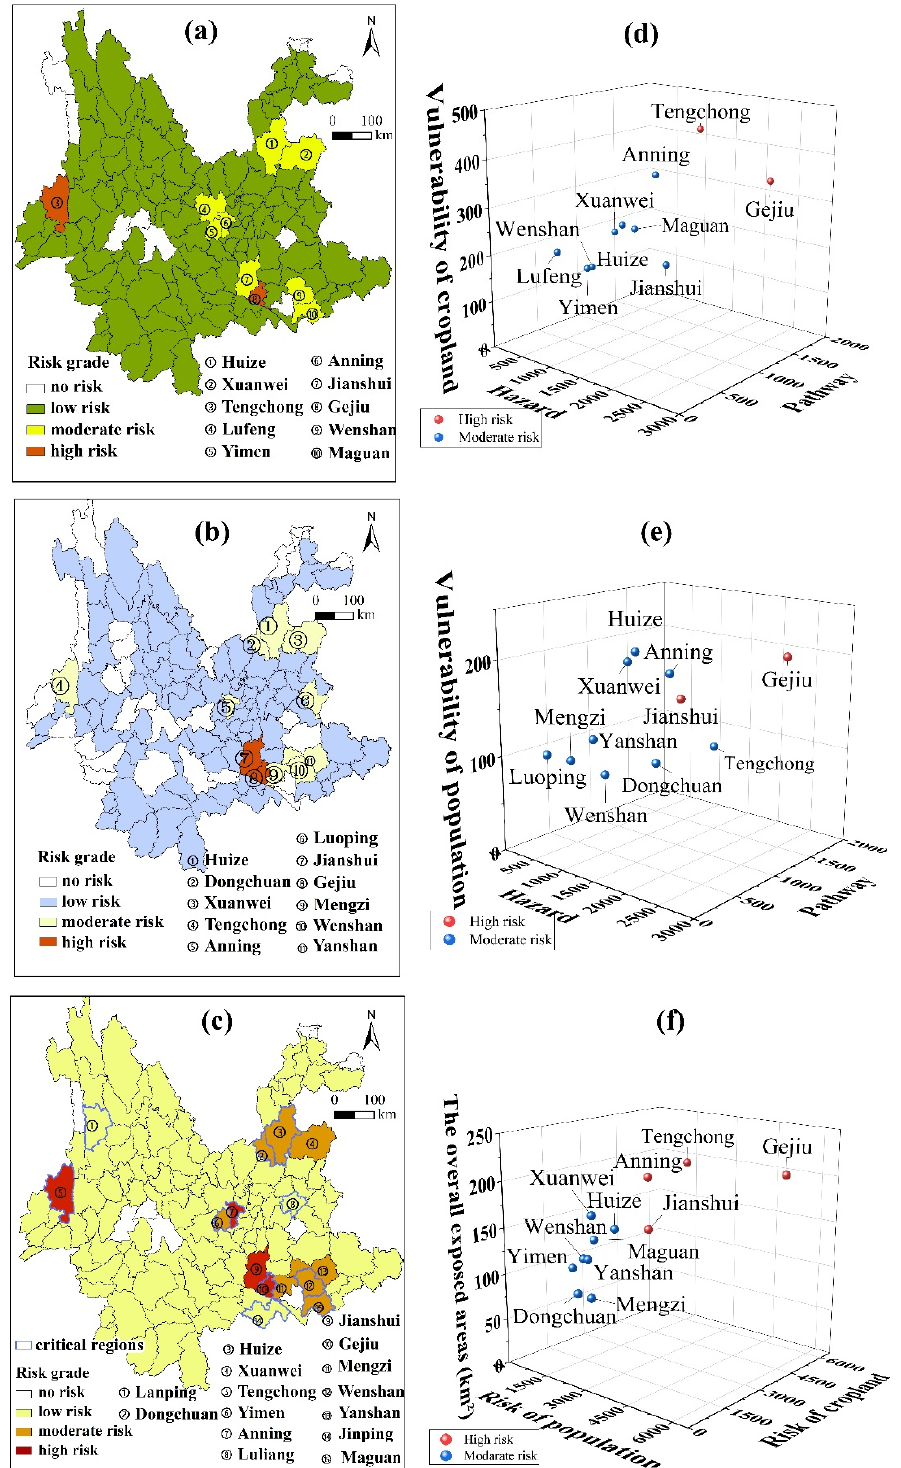
Figure 8. Risk assessment at the county scale for ( a ) cropland, ( b ) the sensitive population, and ( c ) the overall risk in Yunnan. The critical regions are outlined in blue in ( c ) and are recognized as crucial metal pollution regions by the national government. Decomposition of high-risk and moderate-risk regions for ( d ) croplands, ( e ) sensitive population, and ( f ) the overall